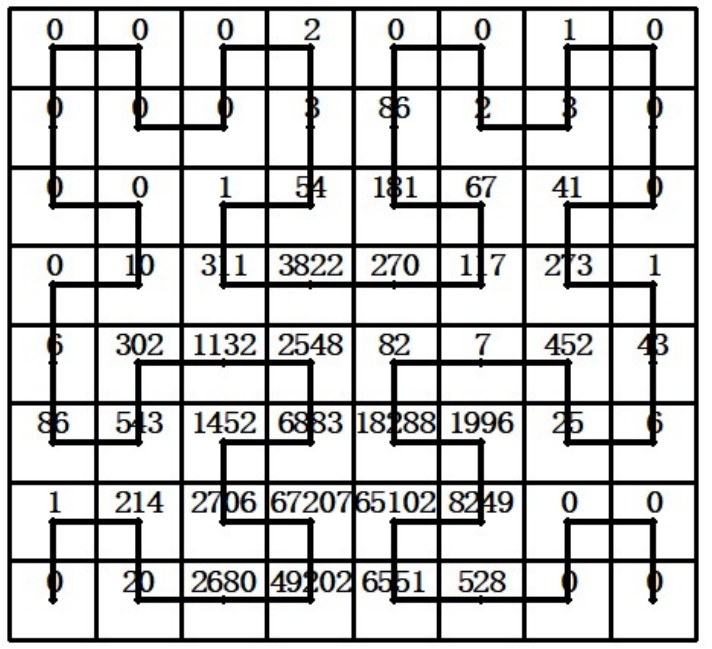
Figure 4. Distribution of the number of objects in the partial data grid (the data in the grid represent